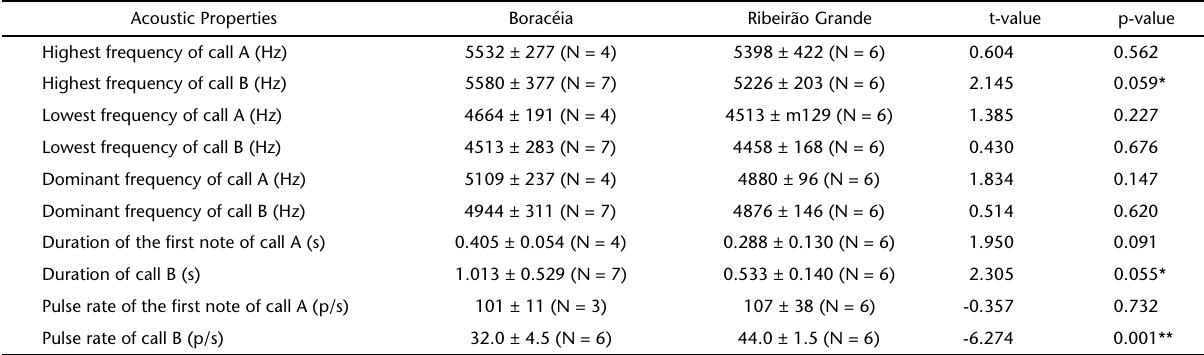
Table 2. Call properties of the two populations of Dendropsophus microps studied. The values represent mean ± SD, and N = number of males. Results of the two-sample t-tests are included. Acoustic